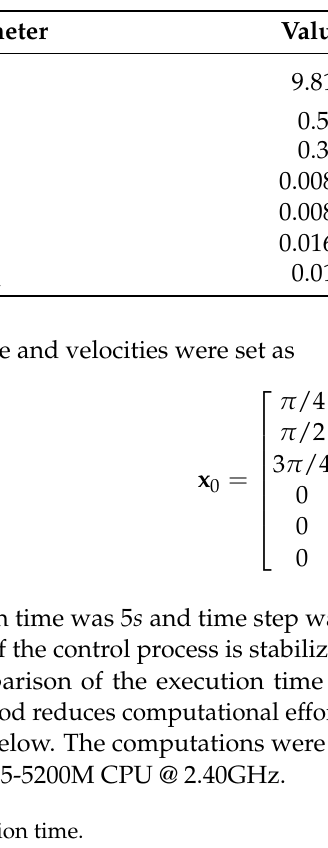
Table 1. Parameters used in simulation.